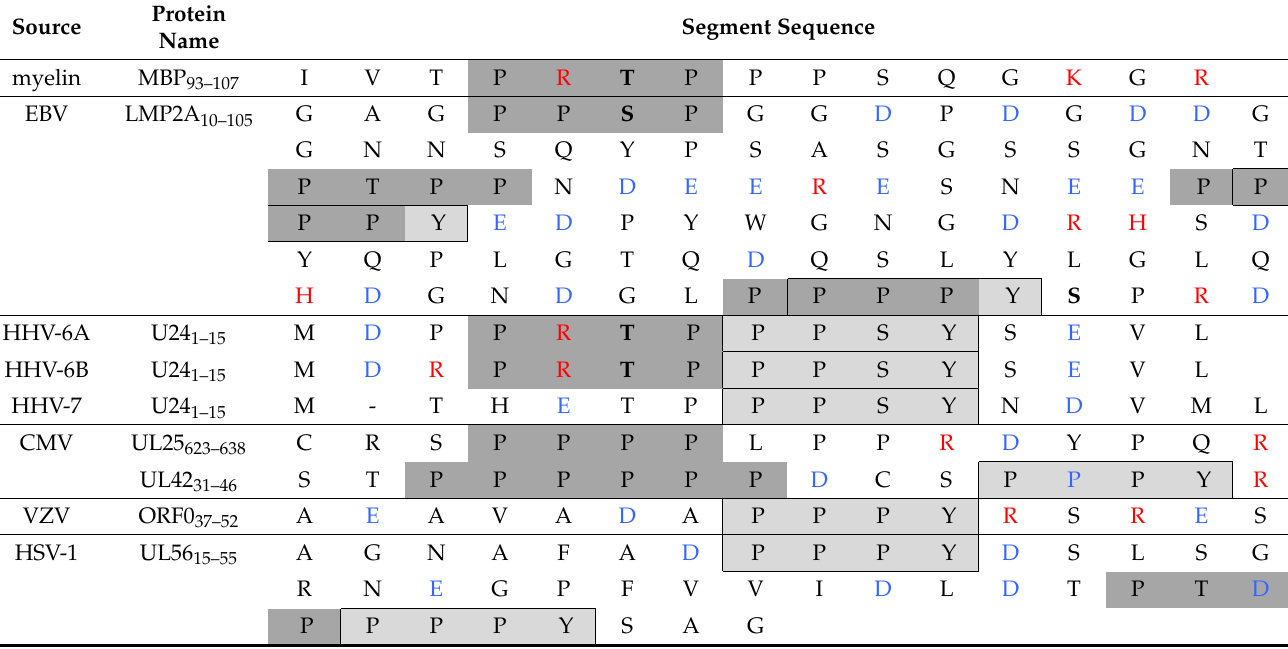
Table 1. Sequence alignment of a number of key segments from proteins which are implicated in MS. Amino acids with negatively charged side-chains are indicated in blue, whereas those with positive side-chains are shown in red. The PxxP motifs are indicated with dark grey shading. The PPxY motifs are shaded in light grey and boxed. Residues that are phosphorylated are shown in